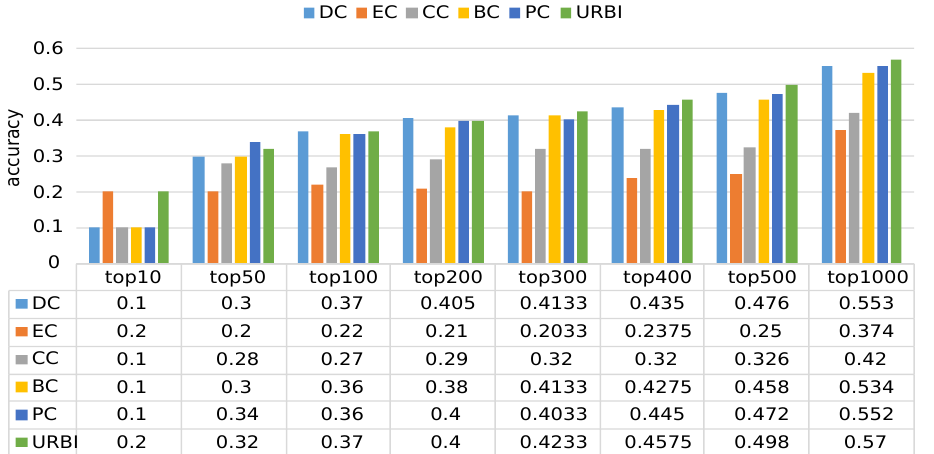
Figure 11. This figure depicts the experimental results of dataset No.11, which contains 9075 book nodes.